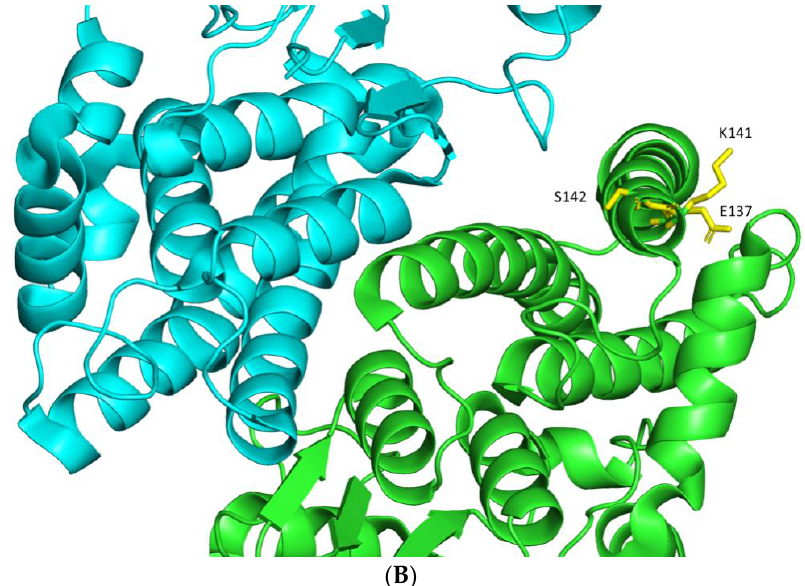
Figure 2. Computational assessment of hGSTA1-1 flexibility by using DynaMut [27]. ( A ) Amino acids are colored according to the vibrational entropy change upon mutation. The blue color represents a rigidification of the structure, and the red one a gain in flexibility. ( B ) The positions of the selected residues are shown in the native structure hGSTA1-1 (PDB code: 1PKZ) as sticks of yellow color. The different chains of the dimer are depicted in cyan and green color. The figure was created using the PyMOL Molecular Graphics System [30].